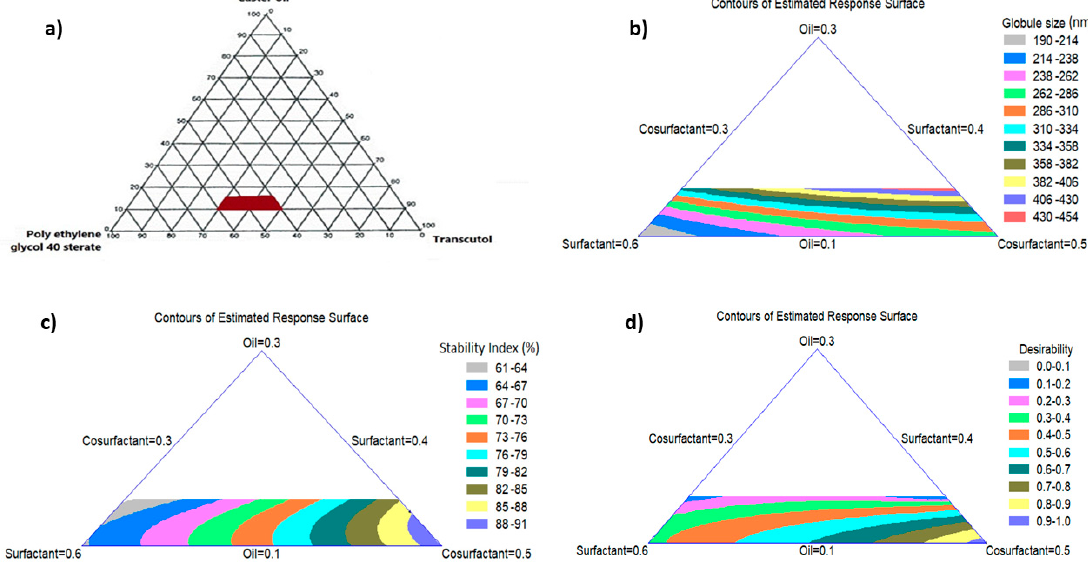
Figure 2. Pseudo-ternary phase diagrams of the selected nanoemulsion system ( a ), Two-dimensional (2D) contour plots of the estimated response surface for the effect of variables on FBX-SNEDS ( b – d ). The red area in figure ( a ) represents the clear nanoemulsion region that was selected as a border of the mixture experimental design space.